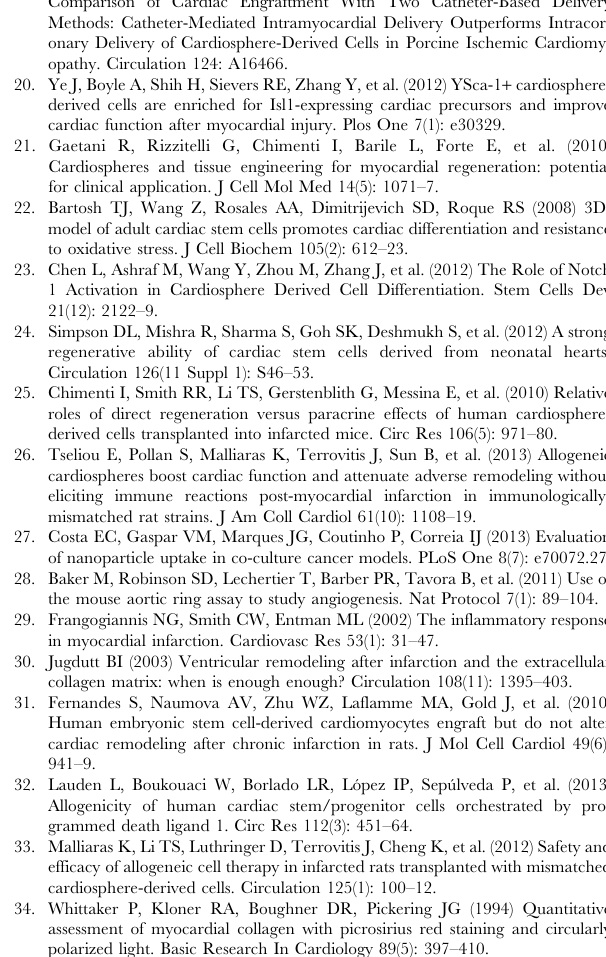
the treated group, but a thinner infarct wall thickness. (C,D,F) Viable mass, scar size and septal thickness were similar between small MI and MI + CSp groups. (G) A significantly higher EF was detected at baseline in the small MI group compared to both placebo and CSp treated, but progressively deteriorated up to 21 days after evaluation. (H) Significant dilation of the LV evaluated with the LVEDD was also present at day 7 and day 21 in the small MI group compared to the CSp treated but, (I) no difference was measured between the two groups as far as the LVPWD is concerned. Data are mean 6 SD. " p , 0.05 control vs MI + CSp, * p , 0.05 vs. sham, # p , 0.05 vs. small MI. Figure S3 Cardiac tissue structure overview. (A–E) Small MI group exerted significant hypertrophy compared to the sham group which was accompanied by significant reduction in the cell nuclei number compared to the sham and the treated group. (F–I) Quantification of cardiomyocyte proliferation in both peri-infarct and remote regions 7 days post MI and treatment. A trend toward enhanced Ki67 + cardiomyocytes without reaching significance compared to the control was observed in the small MI group. Data are mean 6 SD. " p , 0.05 control vs. MI + CSp, * p , 0.05 vs. sham, # p , 0.05 vs. small MI.